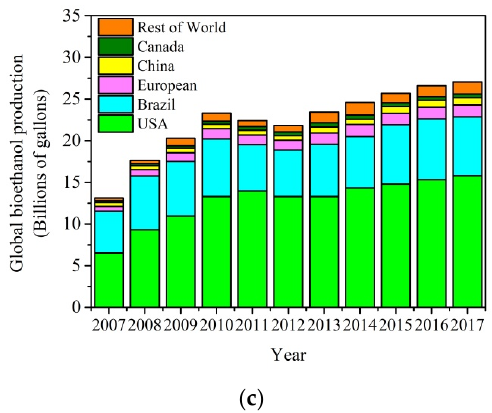
Figure 1. The situation of global and regions biofuel production. ( a ) World biofuel production (adapted from BP 2019 [9]); ( b ) world bioethanol and biodiesel production (adapted from BP 2019 [9]); ( c ) global bioethanol production (source: www.afdc.energy.gov/data/).